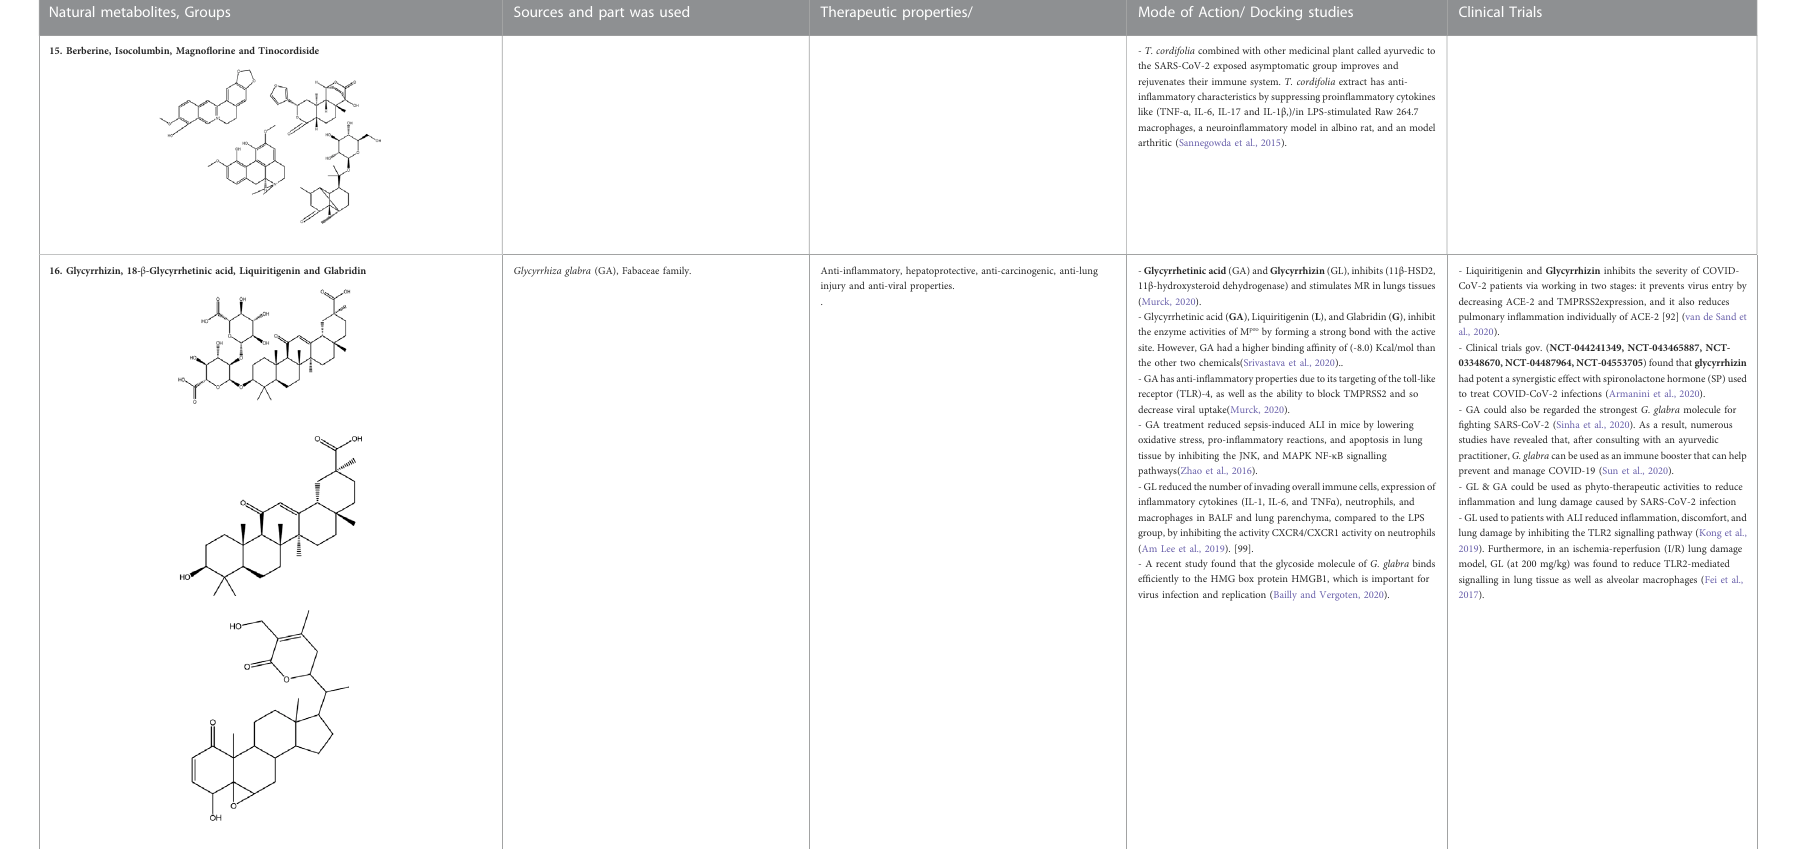
16.Glycyrrhizin,18- β -Glycyrrhetinicacid,LiquiritigeninandGlabridin Glycyrrhizaglabra